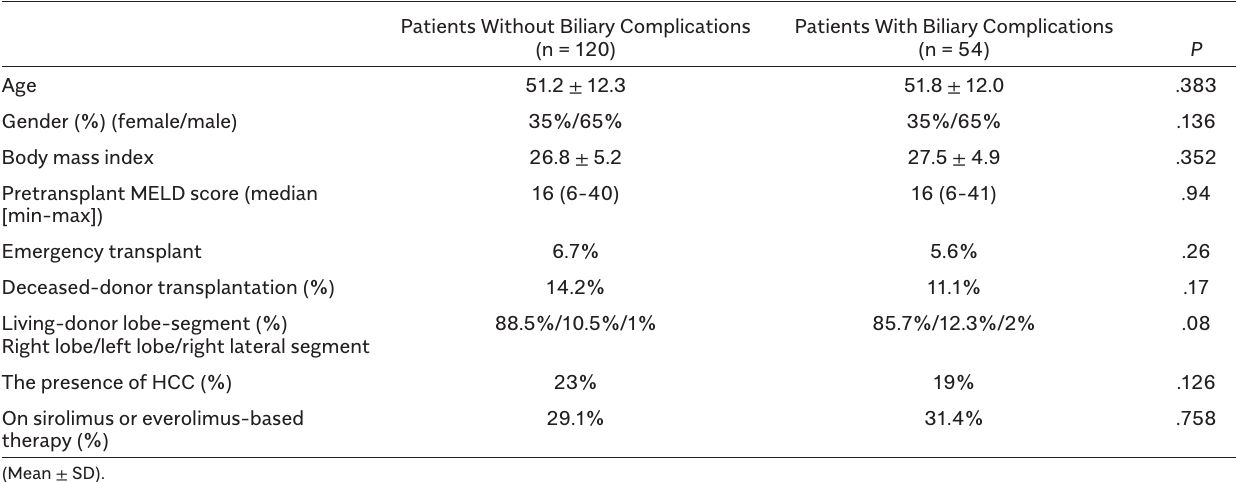
Table 3. Factors Influenced on the Development of Biliary Complications Following LT Patients Without Biliary Complications (n =